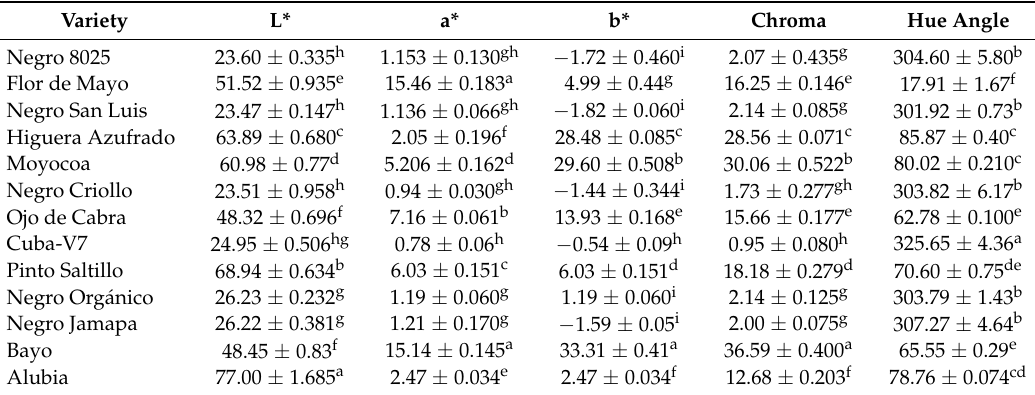
Table 2. Lightness (L*), a* (red-purple) and b* (yellow-purple) color coordinates, hue angle and chroma value observed in common bean